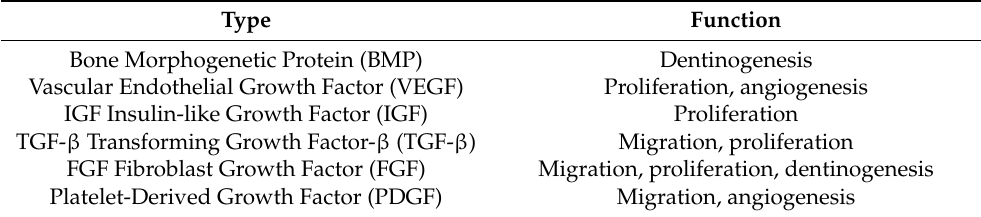
Table 2. Growth factors involved in apexogenesis and